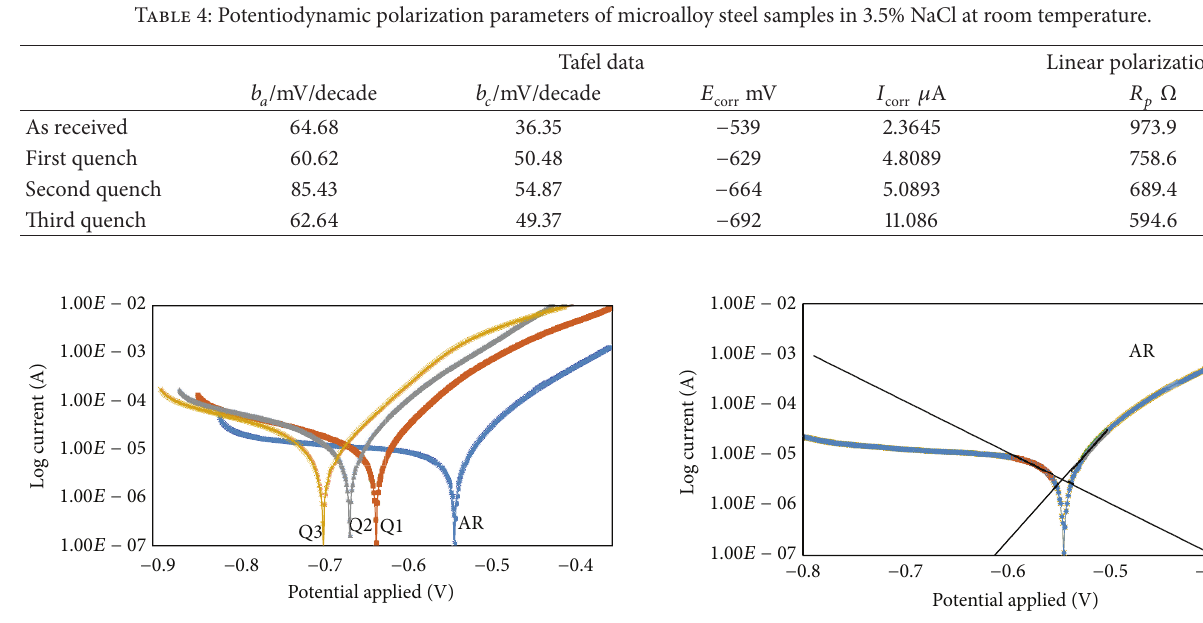
Figure 2: Potentiodynamic polarization curves for microalloy steel samples in 3.5% NaCl at room temperature (AR-as received, Q1-first quench, Q2-second quench, and Q3-third quench).